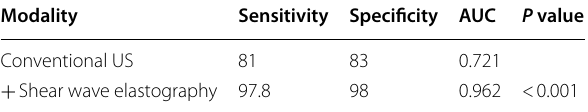
Table 6 Diagnostic performance of combination of conventional high-resolution ultrasonography and shear wave elastography of median nerve using determined cutoffs for elastographic values calculated from ROC